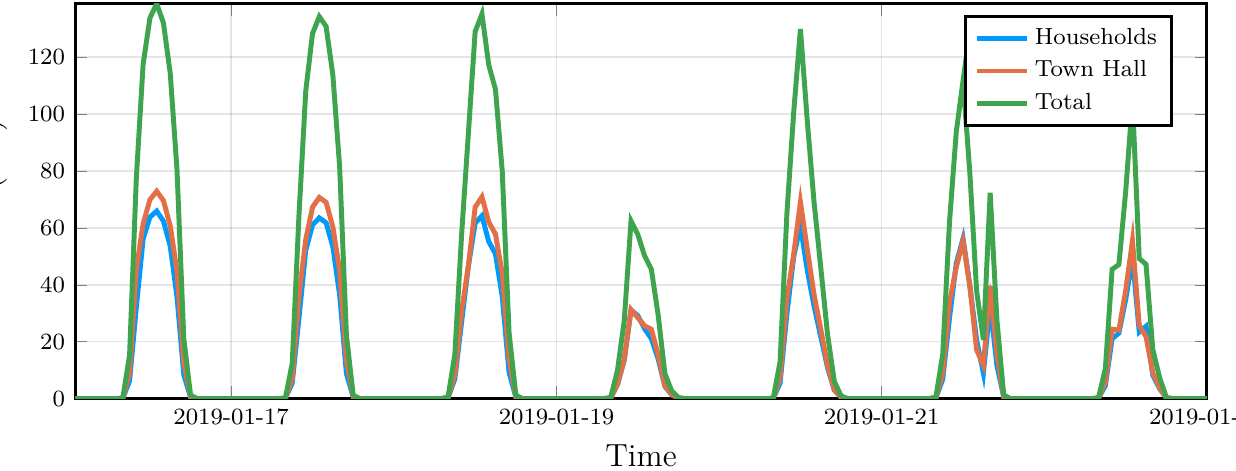
Figure 3. Generation of the community for a winter week